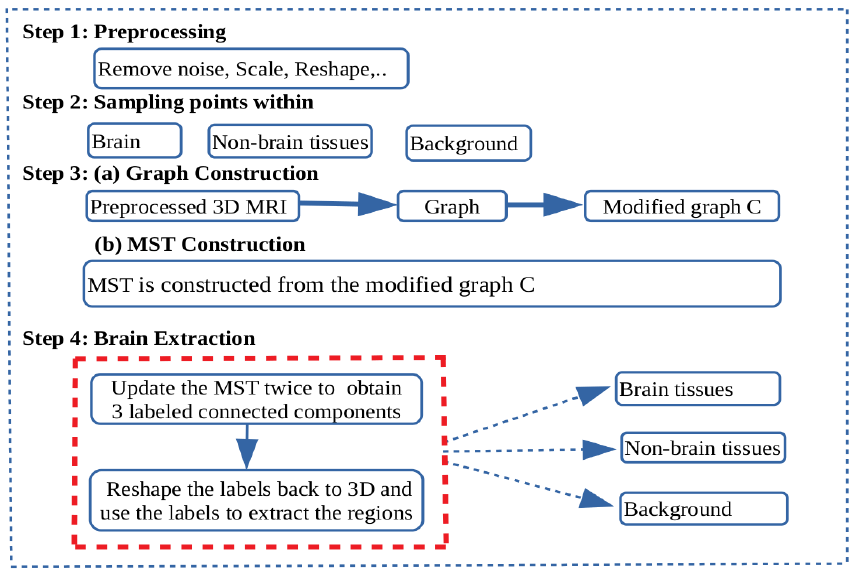
Figure 2. Schematic diagram: Flow diagram showing the steps for brain extraction. Step 1: Pre- processing to remove noise, scale values in the range of 0 and 1 and reshape the 3D magnetic resonance imaging (MRI) volume. Step 2: Sampling points within the brain, non-brain tissues, and the background. Step 3: An adjacency graph weighted by absolute intensity differences is